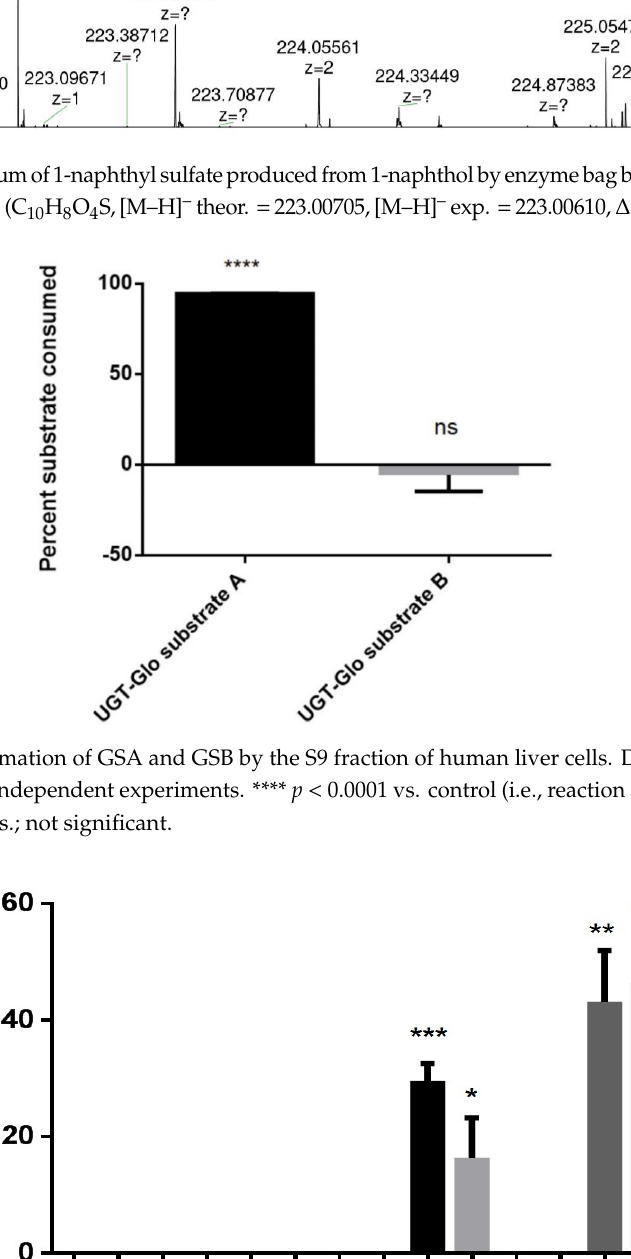
Figure 3. Biotransformation of GSA and GSB by the S9 fraction of human liver cells. Data shown were calculated from two independent experiments. **** p < 0.0001 vs. control (i.e., reaction samples without addition of PAPS); n.s.; not significant.